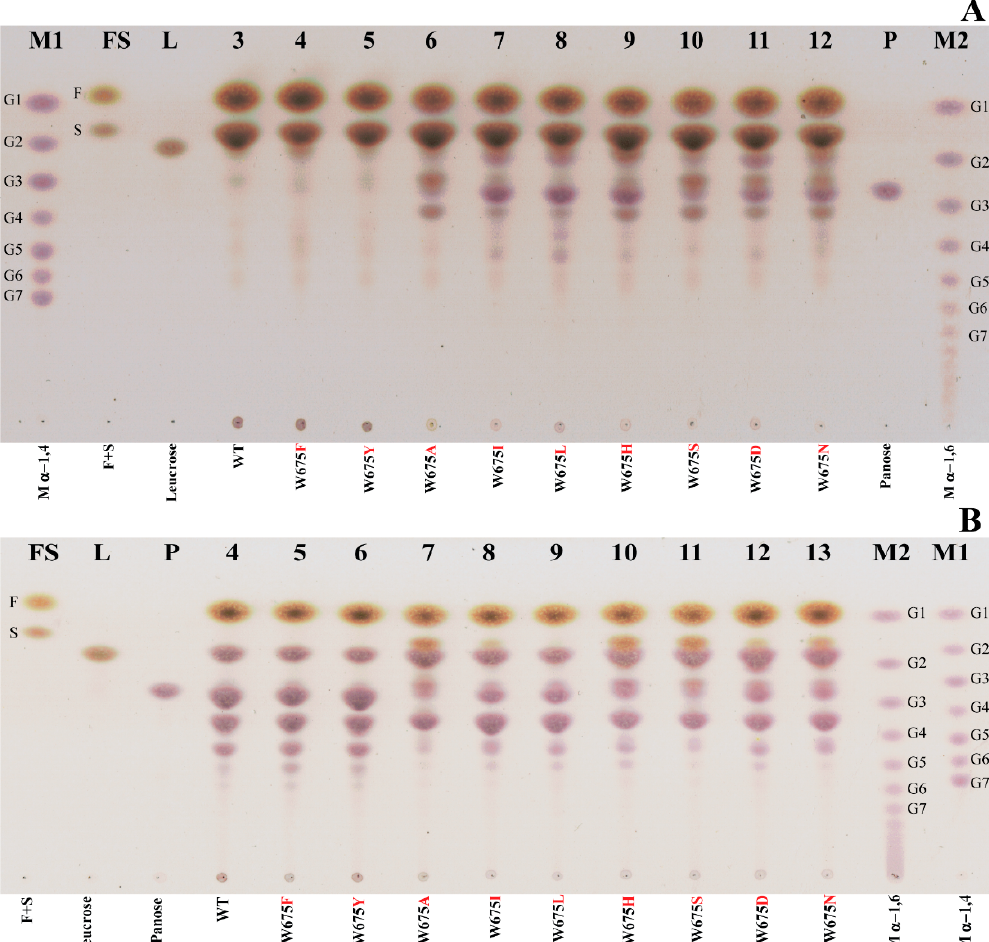
Figure 3. TLC analysis of WT and W675 mutants. ( A ) Products produced from sucrose reactions. ( B ) Products of maltose- acceptor reactions. Lanes M1 and M2— α -1,4 and α -1,6 glucooligosaccharides markers; Lane FS—std. fructose and sucrose; Lane 2—std. leucrose; Lane 13—panose; Lanes 3-12—products from WT, mutants substituted by F, Y, A, I, L, H, S, D, and N, respectively.